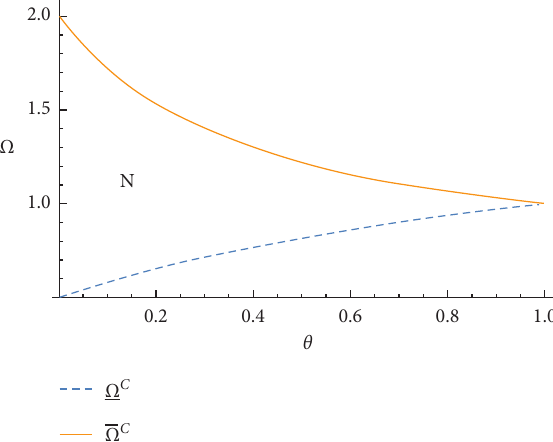
Figure 3: Cooperation mode choice for the common